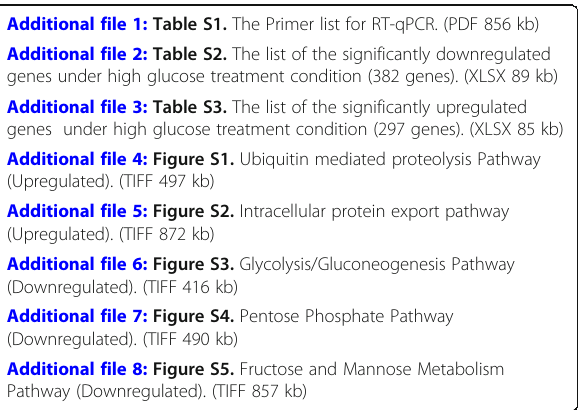
calculate mean fold changes in mRNA levels